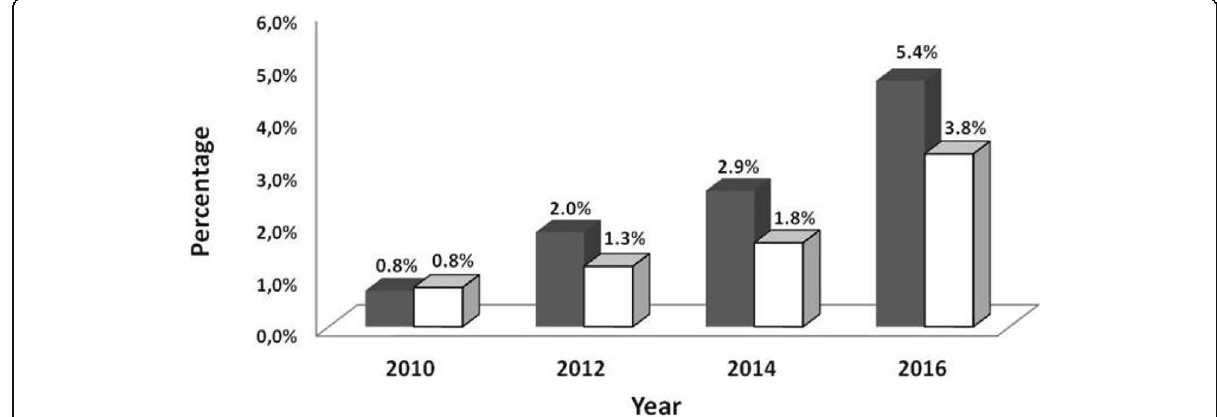
Fig. 3 Rates of mechanical thrombectomy performed in Germany, in urban (grey) and rural (white) areas from 2010 to 2016